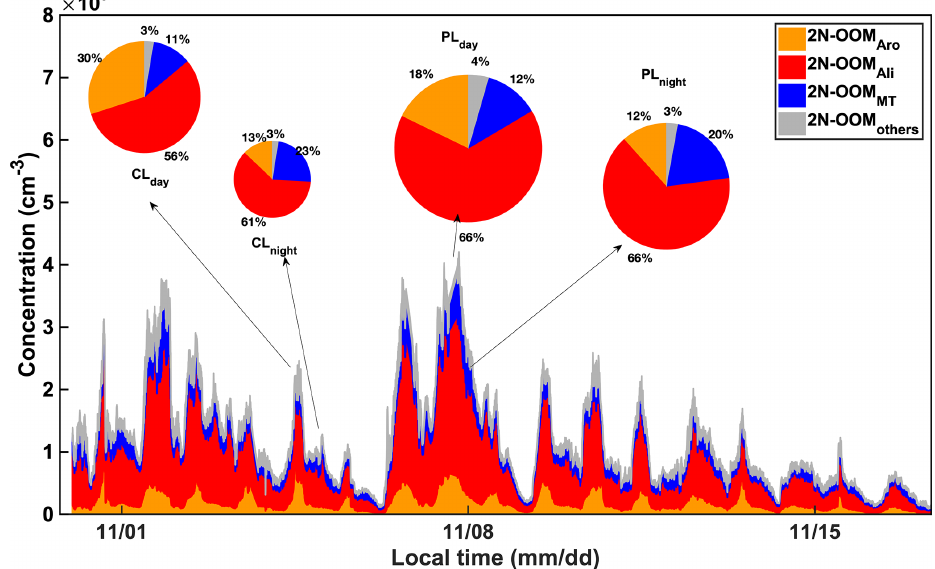
Figure 2. The time series of 2N-OOMs originating from different precursors. Four sub-periods were selected to further investigate the frac- tional distribution of different types of OOMs as shown in the pie charts, including a clean daytime case (12:00 to 14:00LT on 4 November, PM 2 . 5 = 7 . 5µgm − 3 , CL day ), a clean nighttime case (23:00LT on 4 November to 01:00LT on 5 November, PM 2 . 5 = 9 . 5µgm − 3 , CL night ), a daytime case in a PM 2 . 5 episode (12:00 to 14:00LT on 7 November, PM 2 . 5 = 44 . 0µgm − 3 , PL day ) and a nighttime case in a PM 2 . 5 episode (23:00LT on 7 November to 01:00LT on 8 November, PM 2 . 5 = 60 . 5µgm − 3 , PL night ). The sizes of pie charts are scaled to the total concentrations of